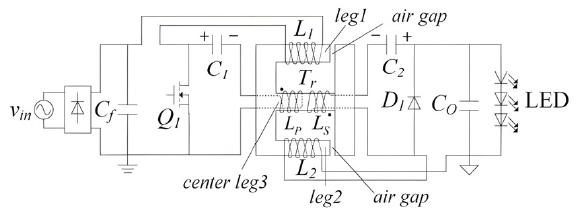
Figure 1. Topology of the flicker-free LED driver with integrated magnetics. Compared with Buck-Boost converter and SEPIC converter, Cuk converter has the following